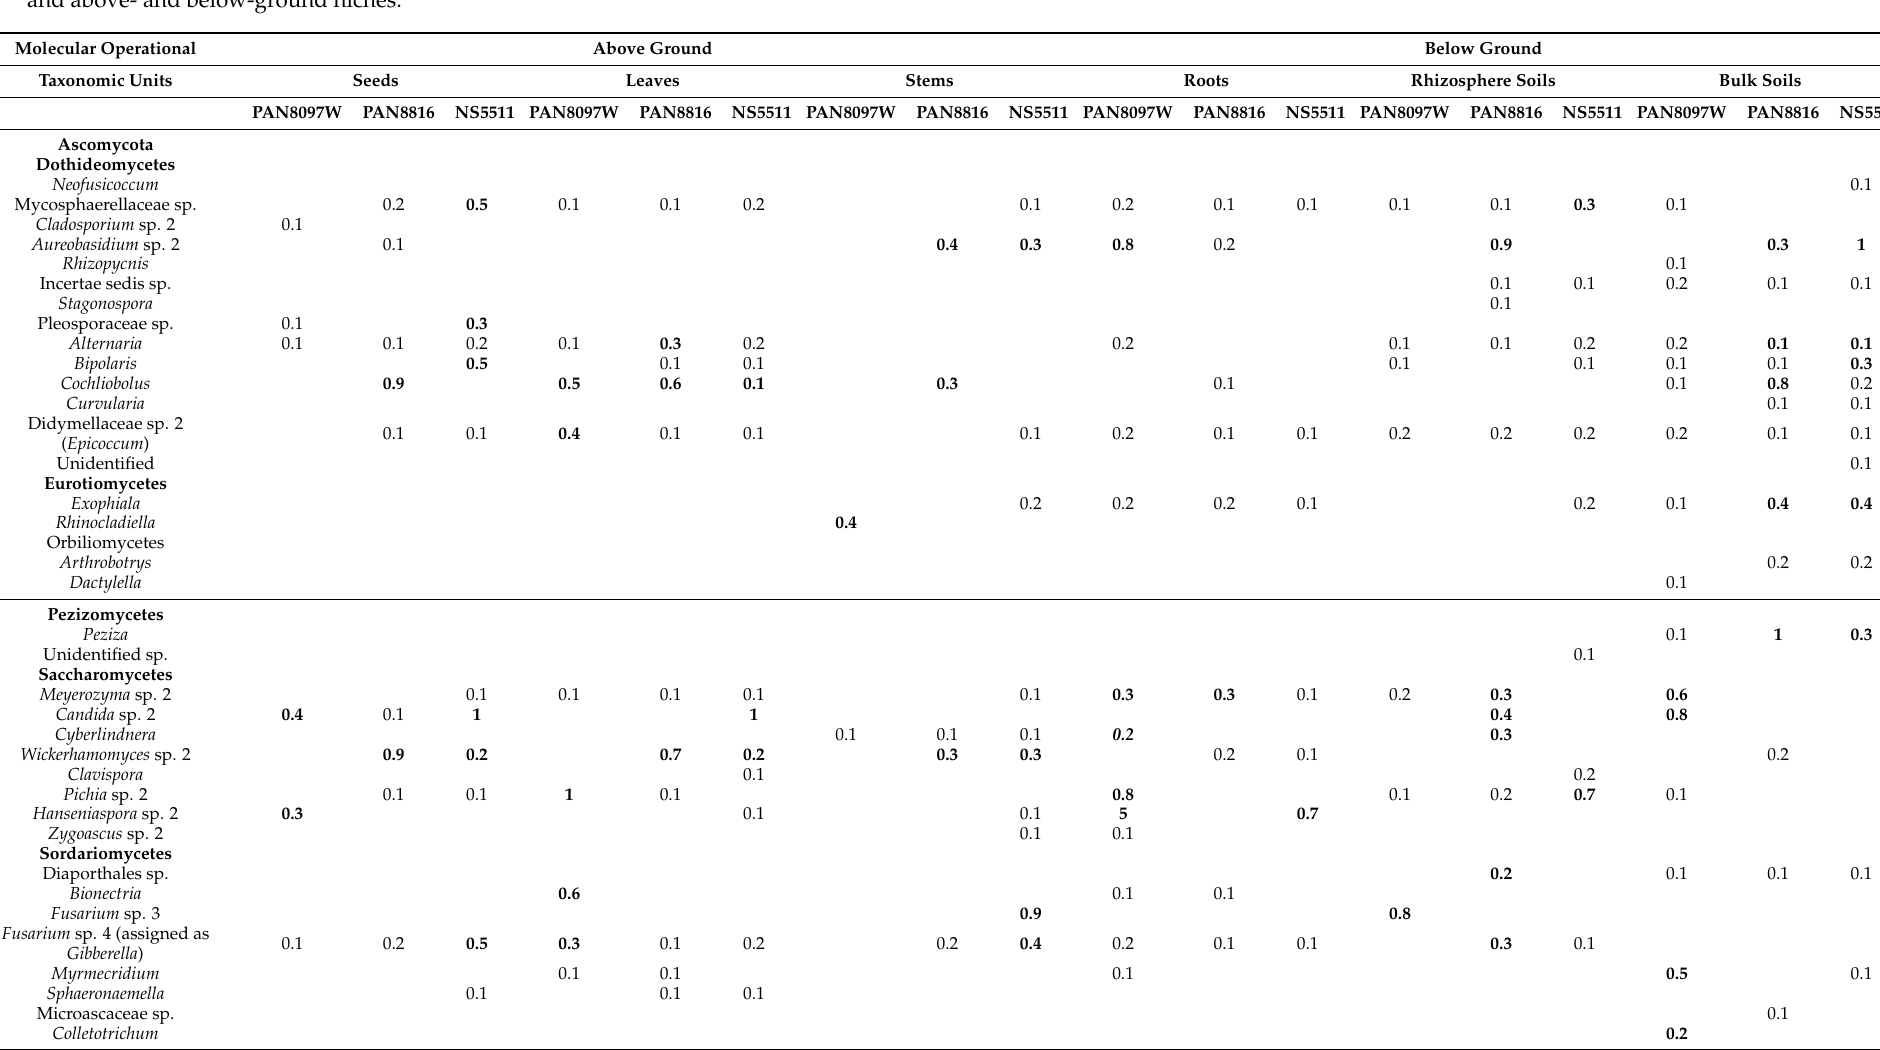
Table 4. Summary of the relative abundance (%) of Molecular Operational Taxonomic Units (MOTUs) that were assigned names with abundances ≤ 1% for the different sorghum cultivars and above- and below-ground